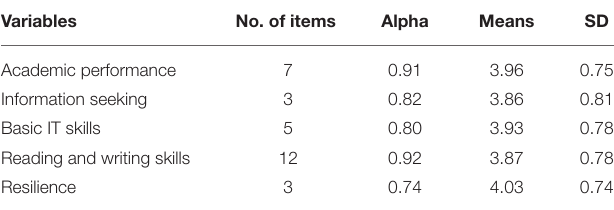
TABLE 2 | Psychometric properties of the predictor and dependent variables.